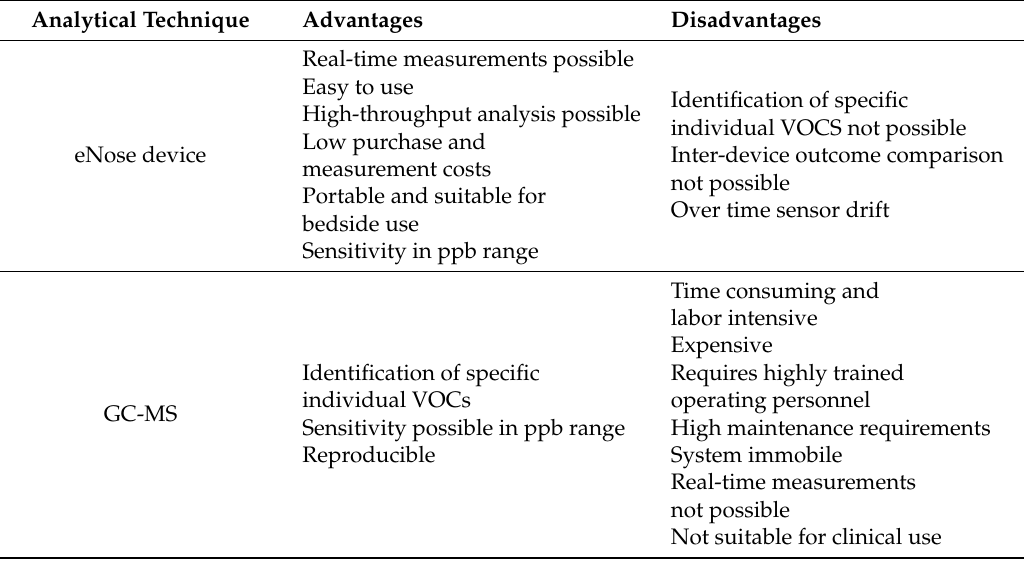
Table 1. Overview of advantages and disadvantages of different analytical